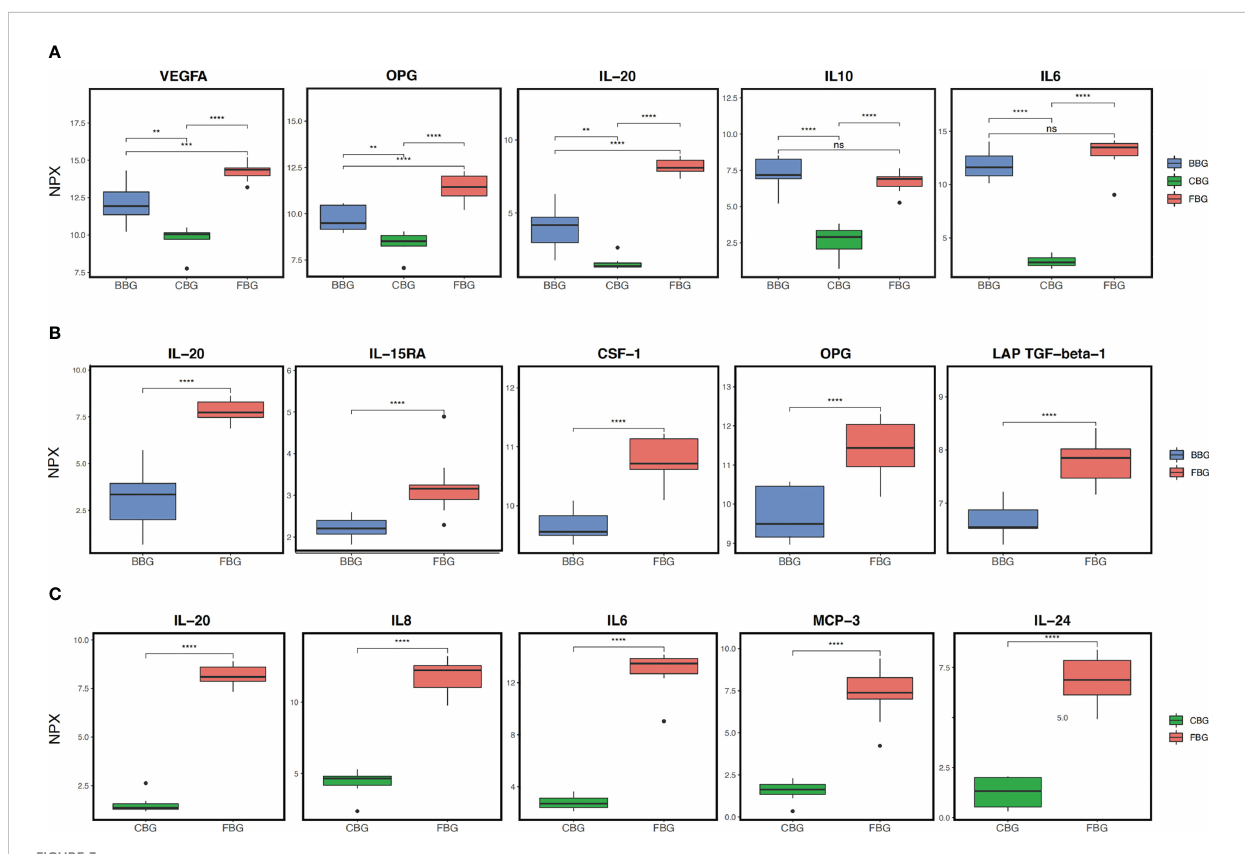
FIGURE 3 Comparison of protein expression in the three groups. (A) Box plots show the top 5 differentially expressed proteins across all three groups as identi fi ed by ANOVA. (B) Box plots show the top 5 differentially expressed proteins between FBG and BBG as identi fi ed by t-test. (C) Box plots show the top 5 differentially expressed proteins between FBG and CBG as identi fi ed by t-test. **p<0.01; *** p<0.001; **** p<0.0001; ns not signi fi